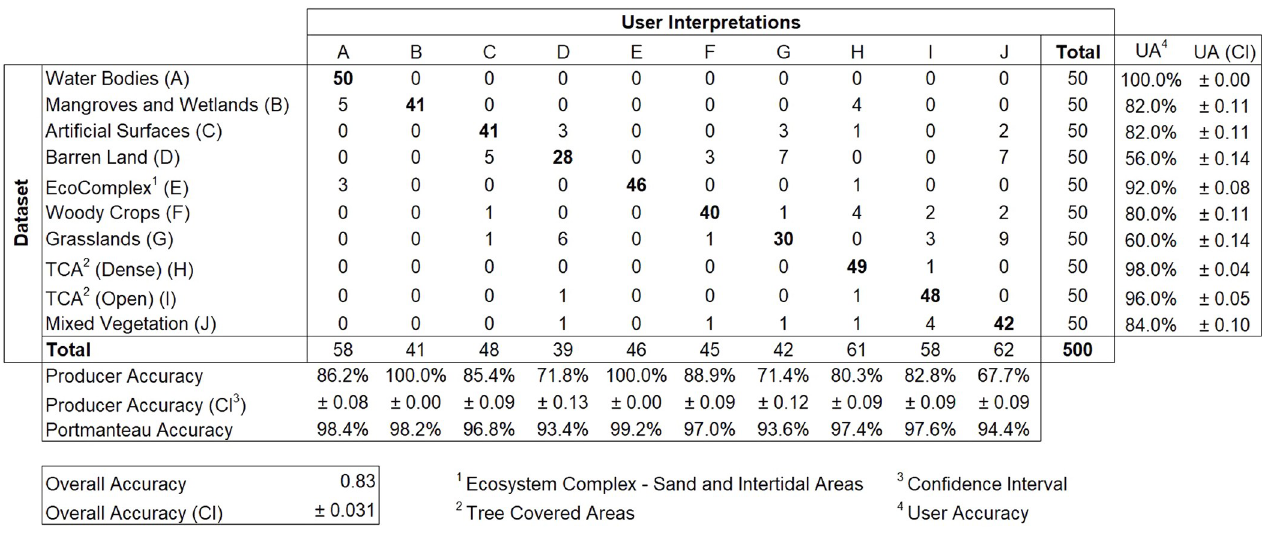
Fig 7. Error matrix for the Liberia land cover map.